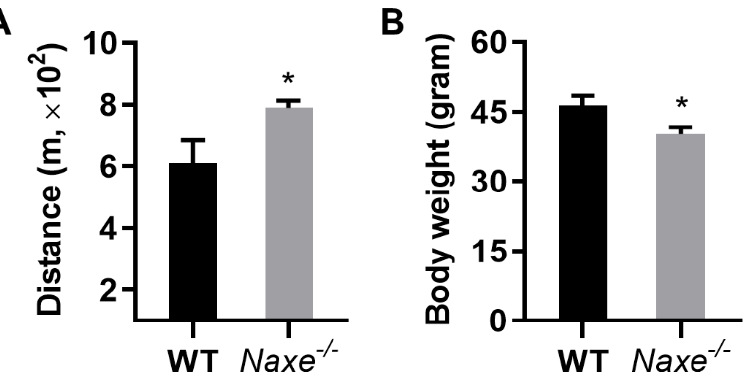
Figure 10. ( A ) Ambulatory performance of control and NAXE knockout mice. The mice were Figure 10. (A ) Ambulatory performance of control and NAXE knockout mice. The mice were trained trained for 3 consecutive days before the endurance assessment. Mouse running was performed and examined individually, with one round of test for a total of 5 control and 6 NAXE knockouts each day. The mice were allowed to rest for one day between two tests. Running distance was recorded and averaged for each mouse. ( B ) Body weight of WT and NAXE knockout mice. Mean ± SE; * p <